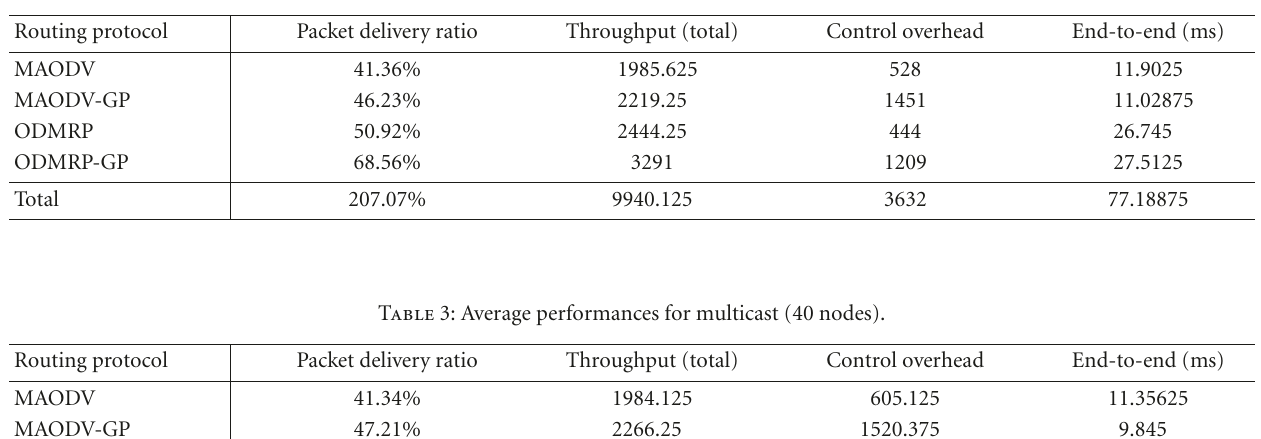
Table 2: Average performances for multicast (50 nodes).